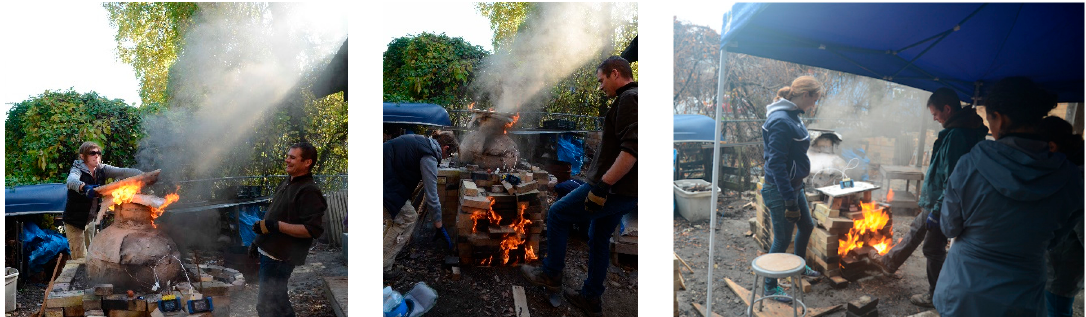
Figure 13. Closing the chimney and firebox to induce reduction results in fire erupting out of both these ports and the production of a gray smoke.